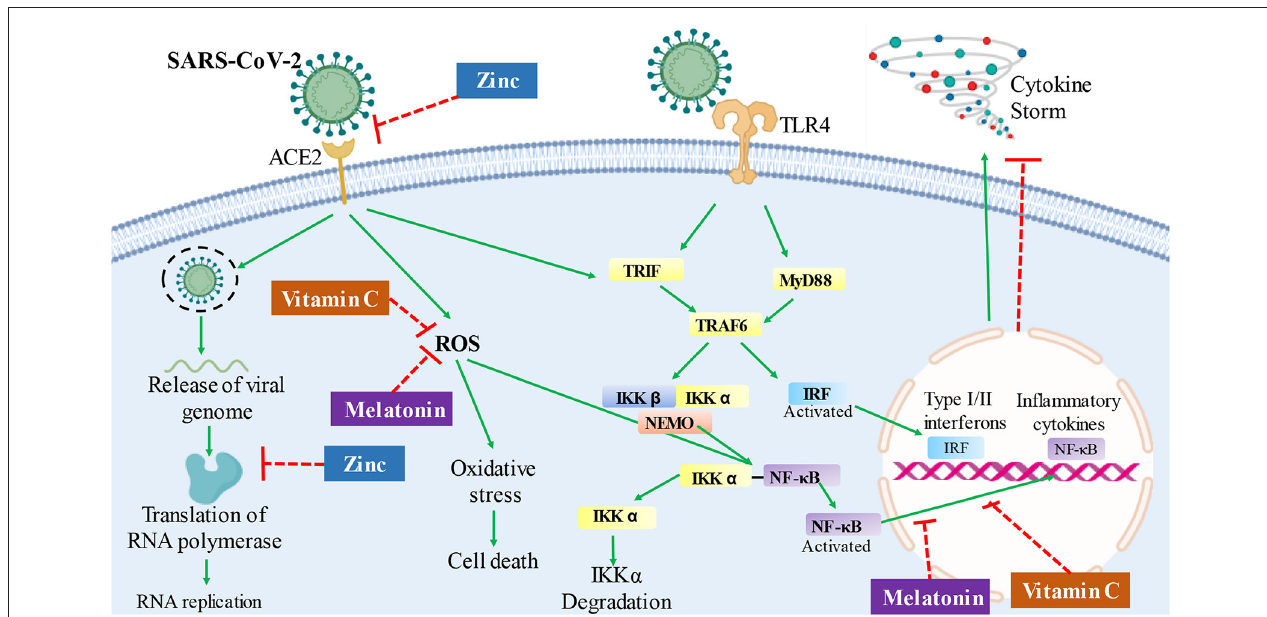
FIGURE 1 | Hypothesis of potential routes and mechanisms, in which melatonin, zinc, or vitamin C therapy could affect the infection response in patients with COVID-19. The overreactive immune system response, followed by severe inflammation and oxidative stress, can contribute to COVID-19 pathology, leading to a cytokine storm. Vitamin C has an antioxidant activity, which could prevent oxidative stress and regulate cytokine production by deactivating the NF-kB signaling cascade in patients with COVID-19. Melatonin also has antioxidant activity and decreases NF-kB activation, which could contribute to the inhibition of cytokine storm. Besides, zinc could act by decreasing viral replication by inhibiting RNA polymerase and reverse transcriptase activity; in addition, it could decrease the expression of the ACE2 receptor and inhibits the interaction of SARS-CoV-2 with this receptor. SARS-CoV-2, severe acute respiratory syndrome coronavirus 2; ACE2, angiotensin-converting enzyme 2; ROS, reactive oxygen species; TLR4, toll-like receptor 4; TRIF, TLR-like receptor-associated interferon factor; MyD88, myeloid differentiation factor 88; TRAF6, tumor receptor-associated factor 6; IKK, ikappaB kinase; NEMO, ikappaB kinase gamma; IRF, interferon regulatory factor; NF- κ B, nuclear factor kappa